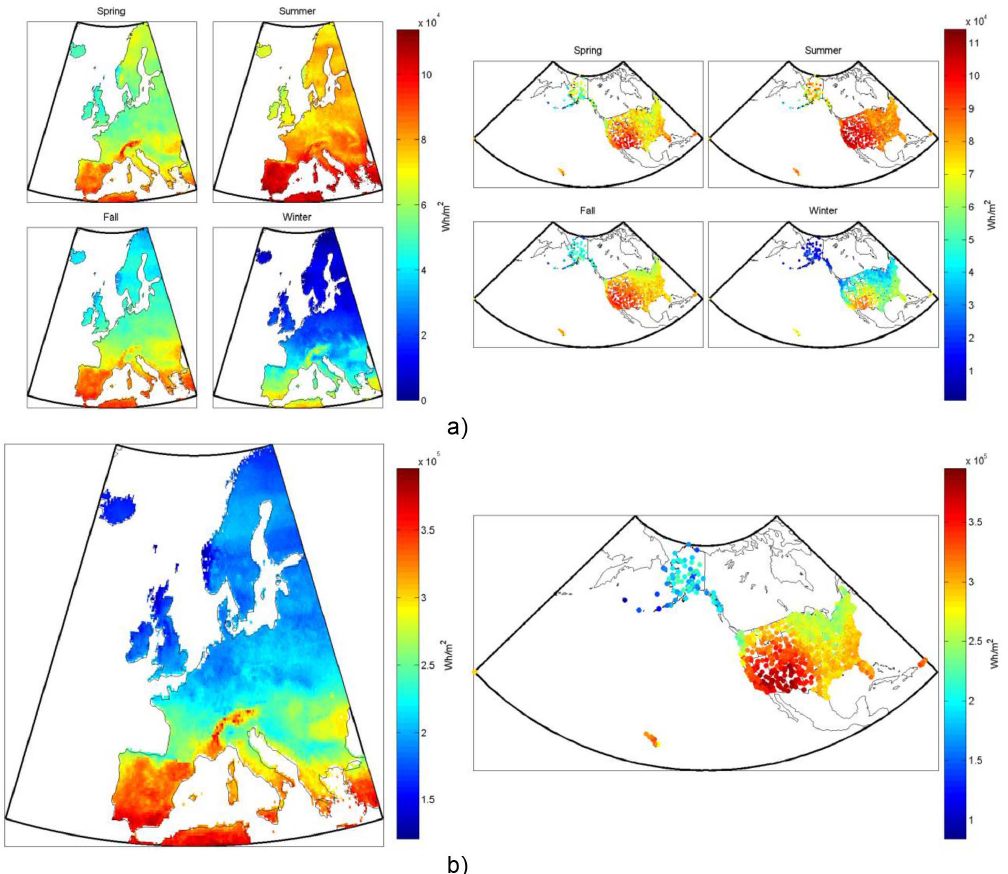
Figure 1. Non-tracking mono-Si PV system’s electricity production, from one square meter of collector, both (a) seasonally and (b) annually in (left) Europe and (right) the